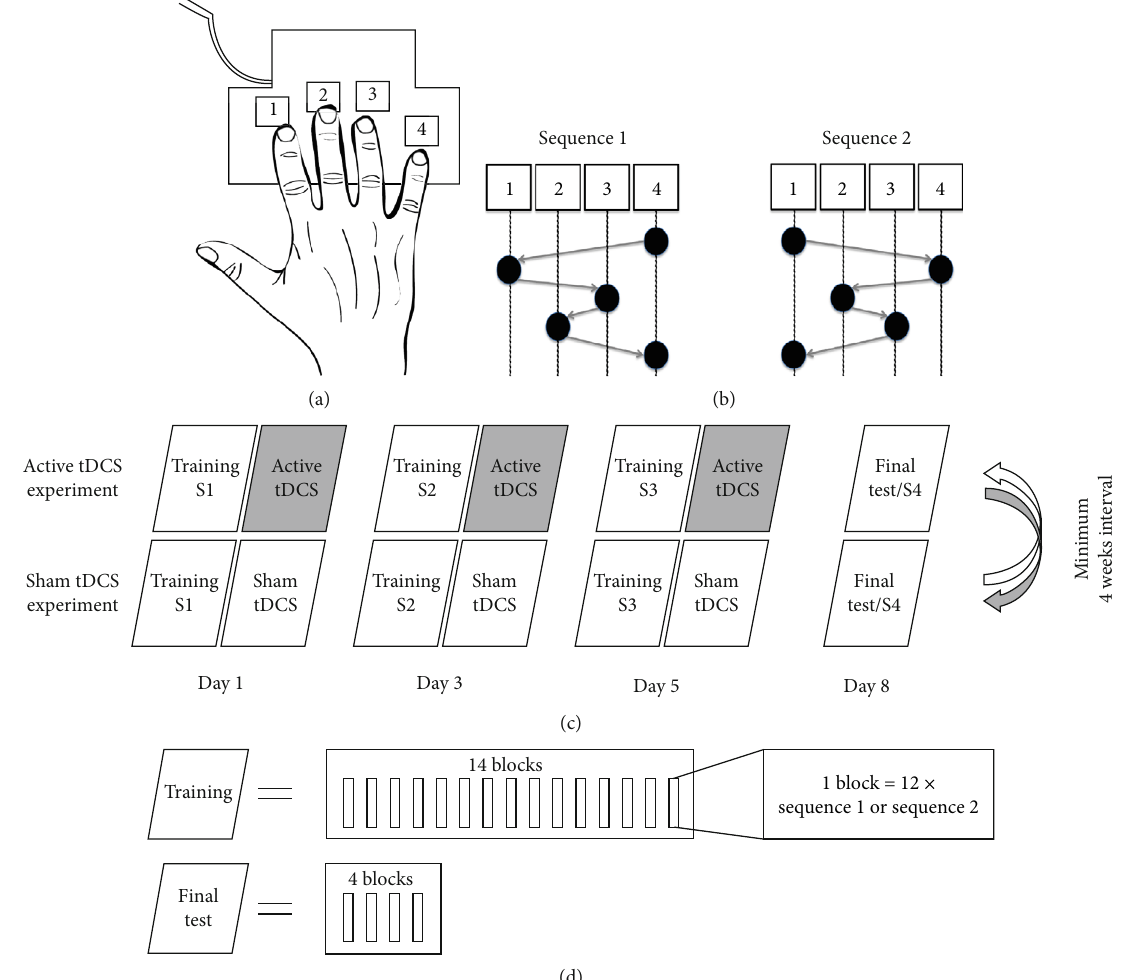
Figure 1: Experimental design. (a) The explicit motor sequence learning task was executed on a four-button gaming keyboard with the right hand. (b) Participants practiced either one of two equally di ffi cult sequences in the active tDCS experiment and the sham tDCS experiment (balanced in terms of order and assignment to the active or sham condition). (c) All participants took part in two experiments, which were separated by at least 4 weeks and corresponded to two types of posttraining tDCS interventions, i.e., active anodal tDCS of the left primary motor cortex and sham tDCS. Each experiment encompassed three training sessions on day 1 (S1), day 3 (S2), and day 5 (S3) and a fi nal test on day 8 (S4). Posttraining tDCS was applied with the anode placed over the left primary motor cortex and the cathode placed over the right supraorbital region. (d) Each training session consisted of 14 blocks of task training, in which each encompassed the execution of 12 sequences (i.e., 60 button presses). The fi nal test consisted of four blocks of the